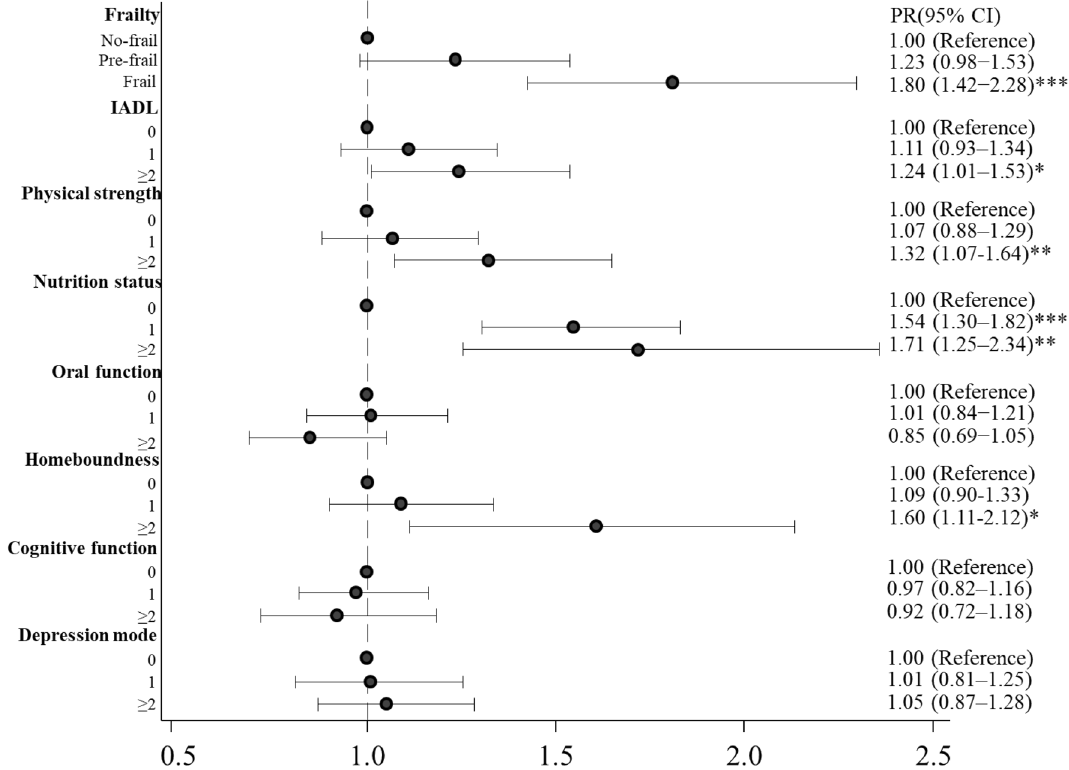
Figure 2. Prevalence ratios (PR) and 95% confidence intervals (95% CIs) of associations between the hospitalization due to pneumonia and frailty or each of the Kihon checklist (KCL) categories in community- dwelling older adults. Numbers in KCL scores represent how many questions were applicable to older adults. * p < 0.05, ** p < 0.01, *** p < 0.001. IADL, Instrumental Activity of Daily